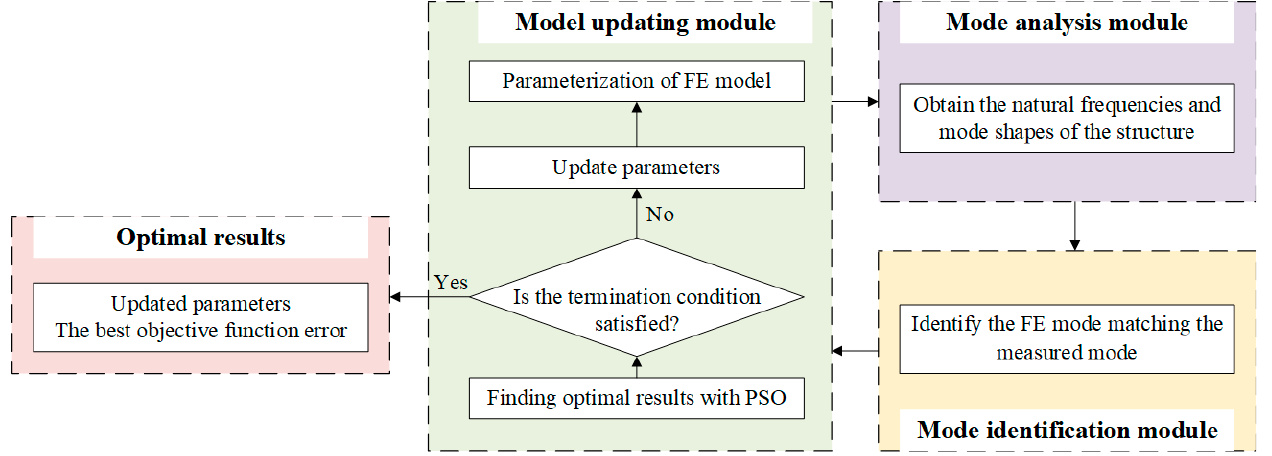
Figure 9. Flow diagram of the model-updating method with automatic mode identification.